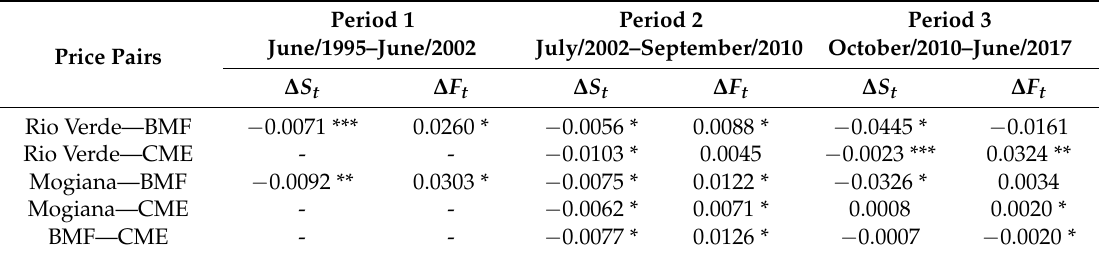
Table 4. Estimated coefficients for the error-correction terms in the vector error correction model (VECM) with spot ( S ) and futures ( F )